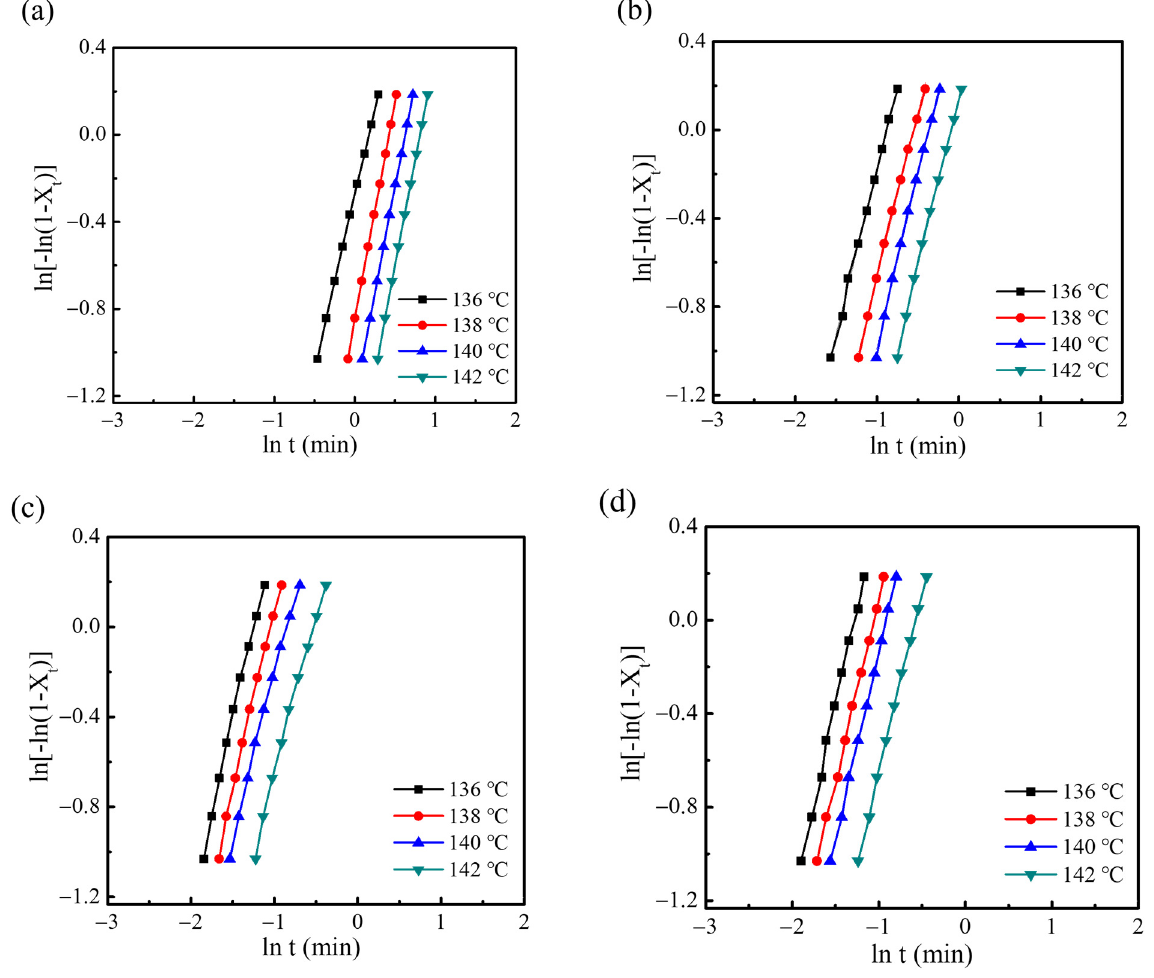
Figure 8. DSC data for ( a ) g-PBAT-40, ( b ) 1 wt% g-PBAT-40/CNC, ( c ) 2 wt% g-PBAT-40/CNC, and ( d ) 3 wt% g-PBAT-40/CNC nanocomposites.